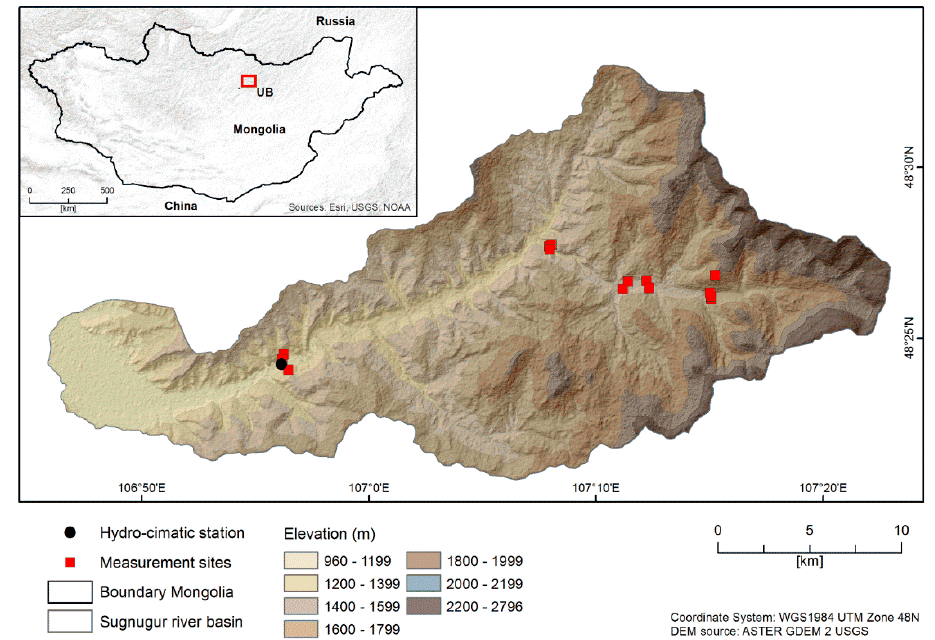
Figure 1. Sugnugur river catchment. Red points indicate the locations of snow field campaigns, as well as the surface temperature measurements. The hydro-climatic station is located at elevation 1193 m.a.s.l. UB is Ulaanbaatar.